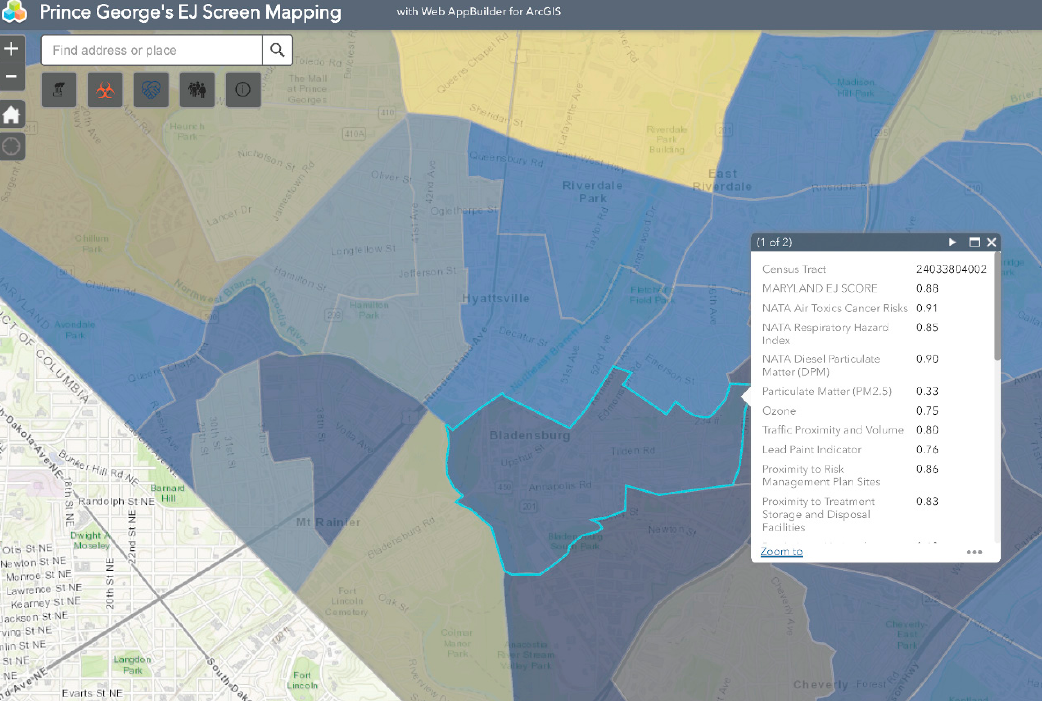
Figure 7 . EPA EJSCREEN side-by-side maps displaying national percentiles for NATA air toxics cancer risk ( left ) and non-White population ( right ).